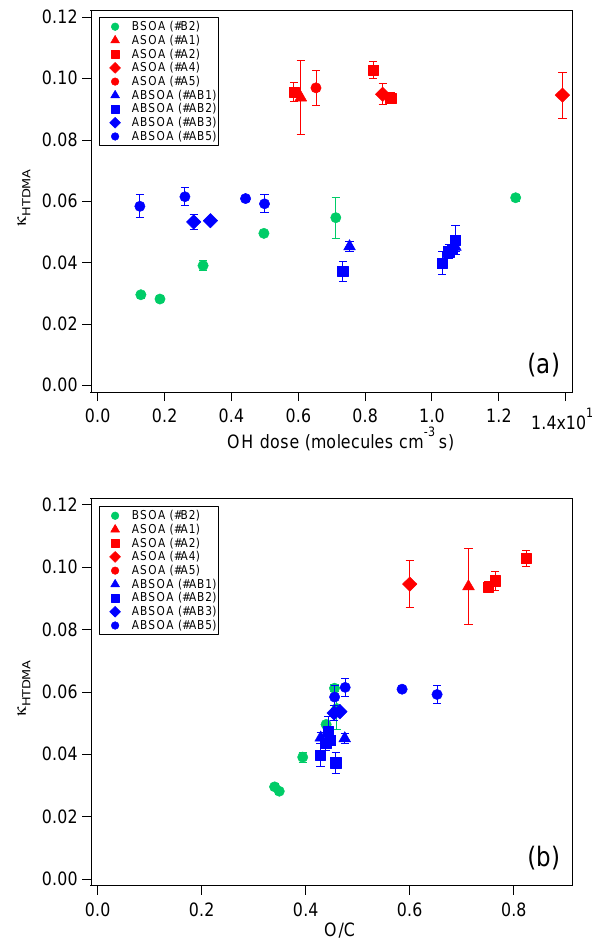
Figure 4. κ HTDMA for BSOA, ASOA, and ABSOA as a function for BSOA, ASOA and ABSOA as a function of OH dose (A) and O/C of 3 Figure 4.  HTDMA of OH dose (a) and O / C of aerosol (b) . ASOA had a distinctively higher κ HTDMA and O / C than aerosol (B). ASOA had a distinctively higher 